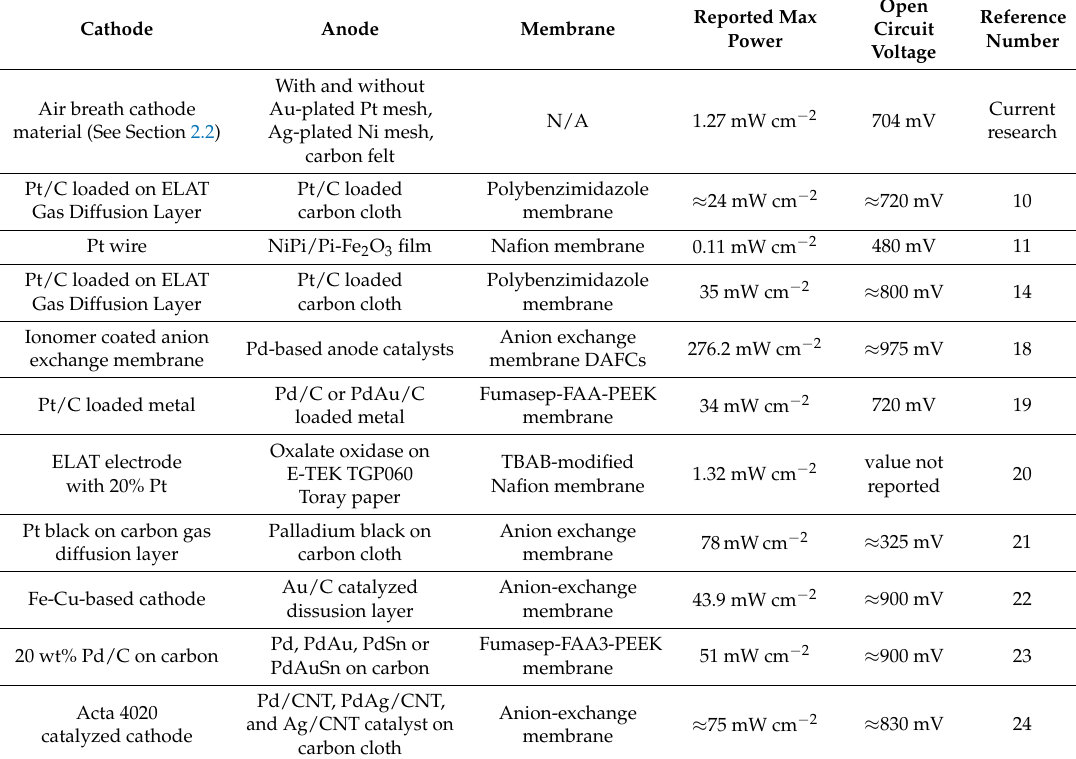
Table A1. A list of references which used membranes as an important component of the fuel cells.